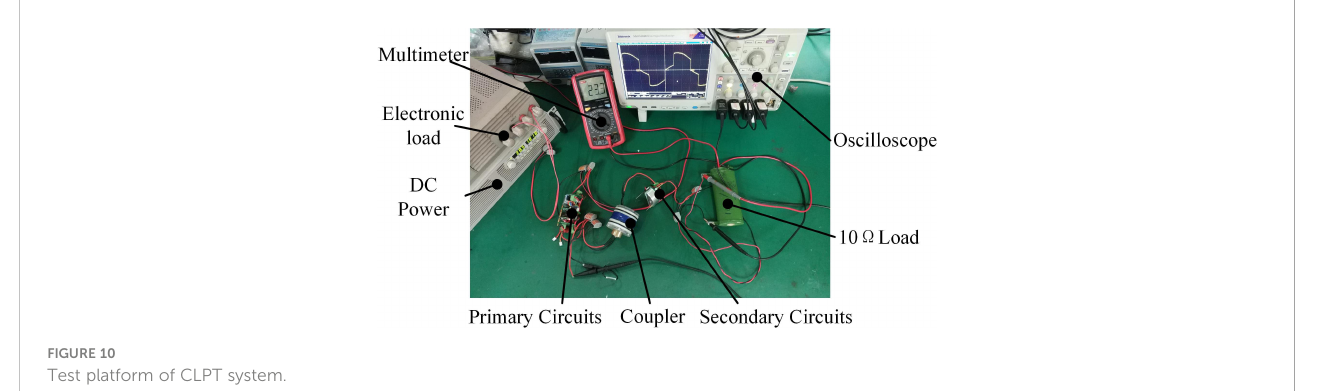
FIGURE 10 Test platform of CLPT system.